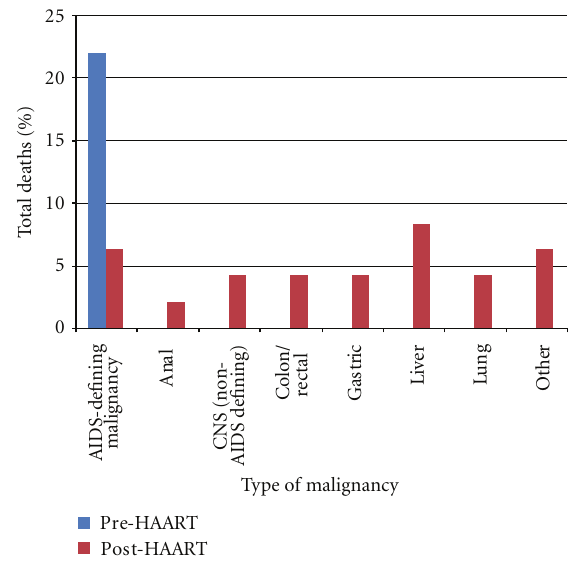
Figure 2: Types of malignancy in individuals who died at Casey House in 1988 (pre-HAART) compared to 2006–2008 (post-